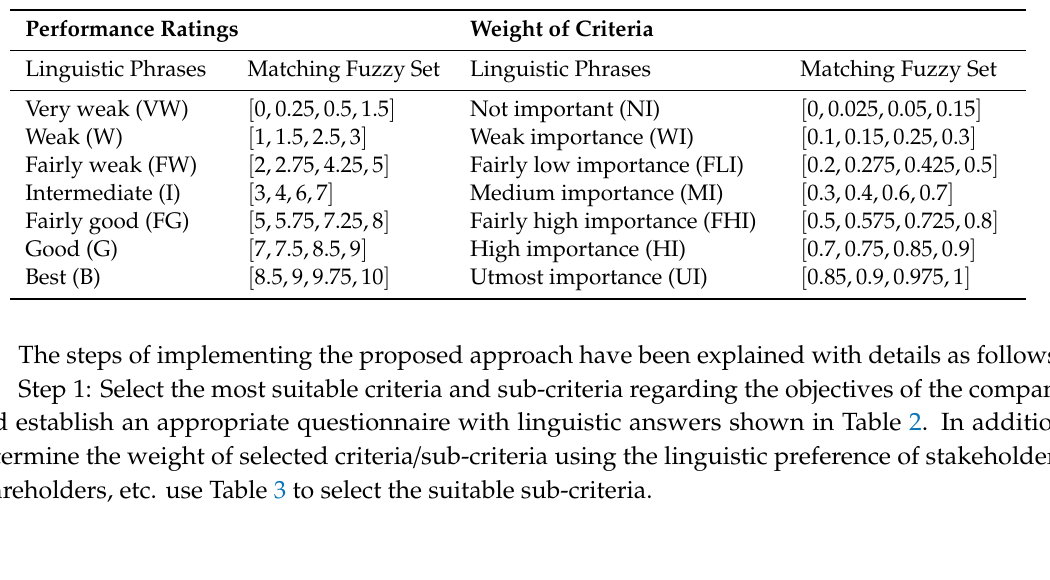
Table 3. List of indicators for the assessment of sustainability in a specific manufacturing company.